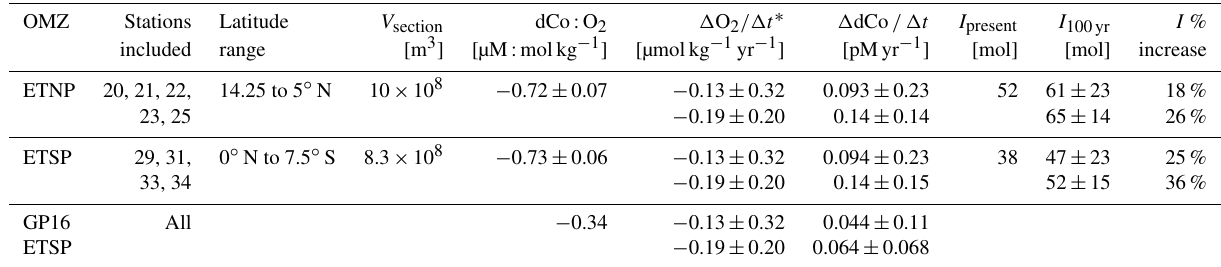
Table 4. Predicted effects of deoxygenation on the dCo inventories ( I ) of the upper 1000m of the eastern tropical North Pacific (ETNP) and eastern tropical South Pacific (ETSP) oxygen minimum zones (OMZs) along the GP15 transect at 152 ◦ W. For comparison, (cid:49) dCo /(cid:49)t was estimated using the dCo:O 2 relationship from the GP16 expedition (Hawco et al., 2016). I present represents the current dCo inventory integrated over the OMZ stations, and I 100yr represents the estimated change in the dCo inventory in 100 years. V section represents the volume of each GP15 section sampled, with a width of 1m and a depth of